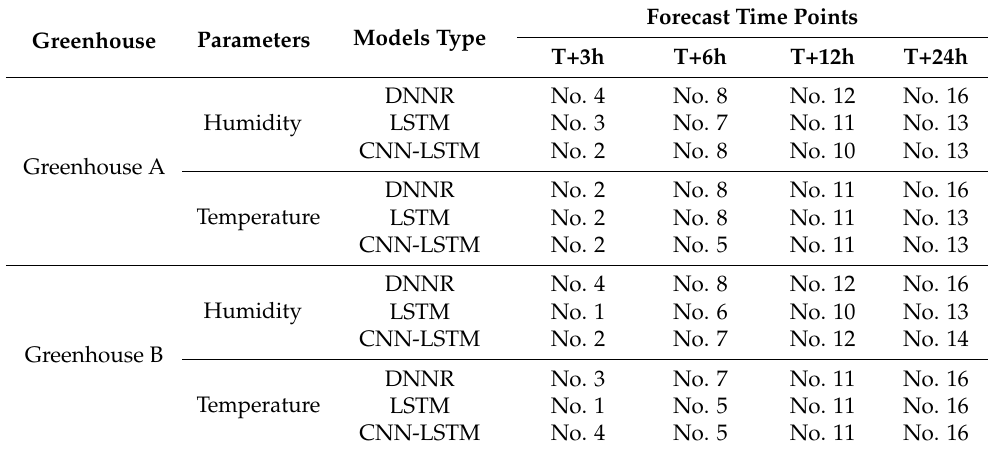
Table 8. The best performing models at each forecast time